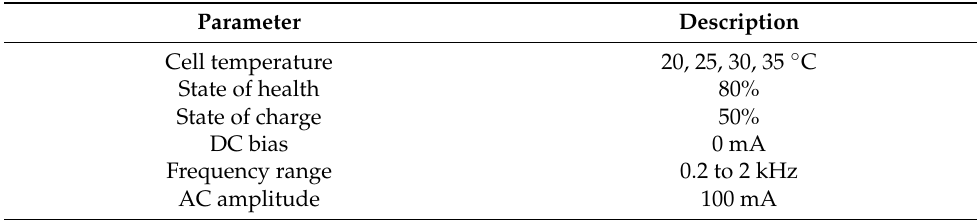
Table 3. Parameters for EIS measurement (Galvanostatic).